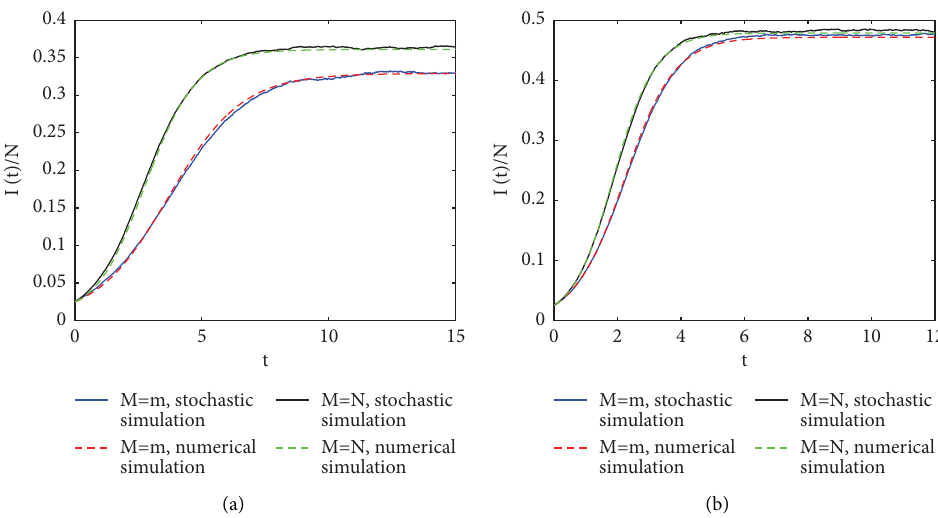
Figure 5: A comparison of stochastic simulations and model predictions of infection dynamics for two limiting cases M � m and M � N . Te parameter values are λ � 0 . 3; c � 1; N � 2000; (a) m � 8, p � 0; and (b) m � 10, p � 0. Red and green lines correspond to numerical solutions of pairwise model ((6a)–(6e)) with the linking mechanism being (7) and (8), respectively. Dashed lines present the average of 250 stochastic simulations according to the algorithm of epidemic spreading on evolving networks in Section